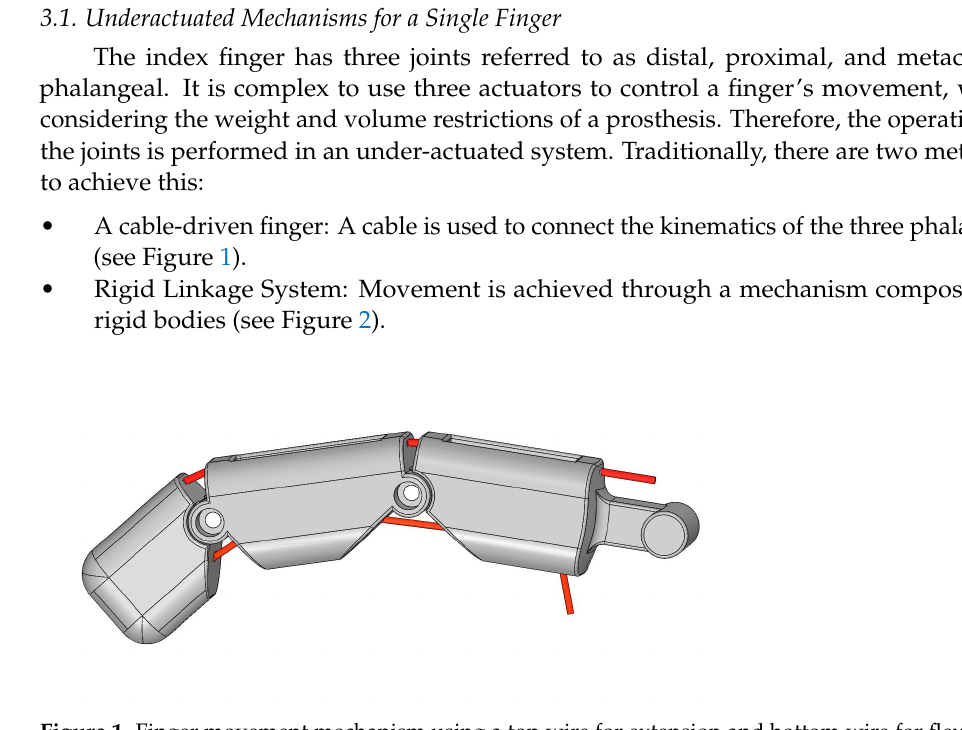
Figure 1. Finger movement mechanism using a top wire for extension and bottom wire for flexion of the finger.